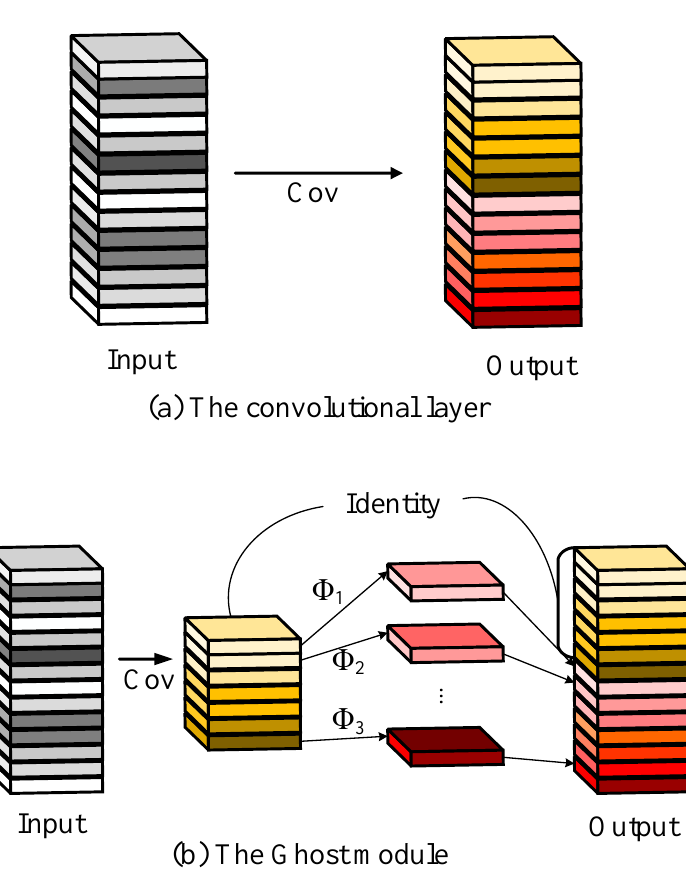
Figure 2. Ghost module.